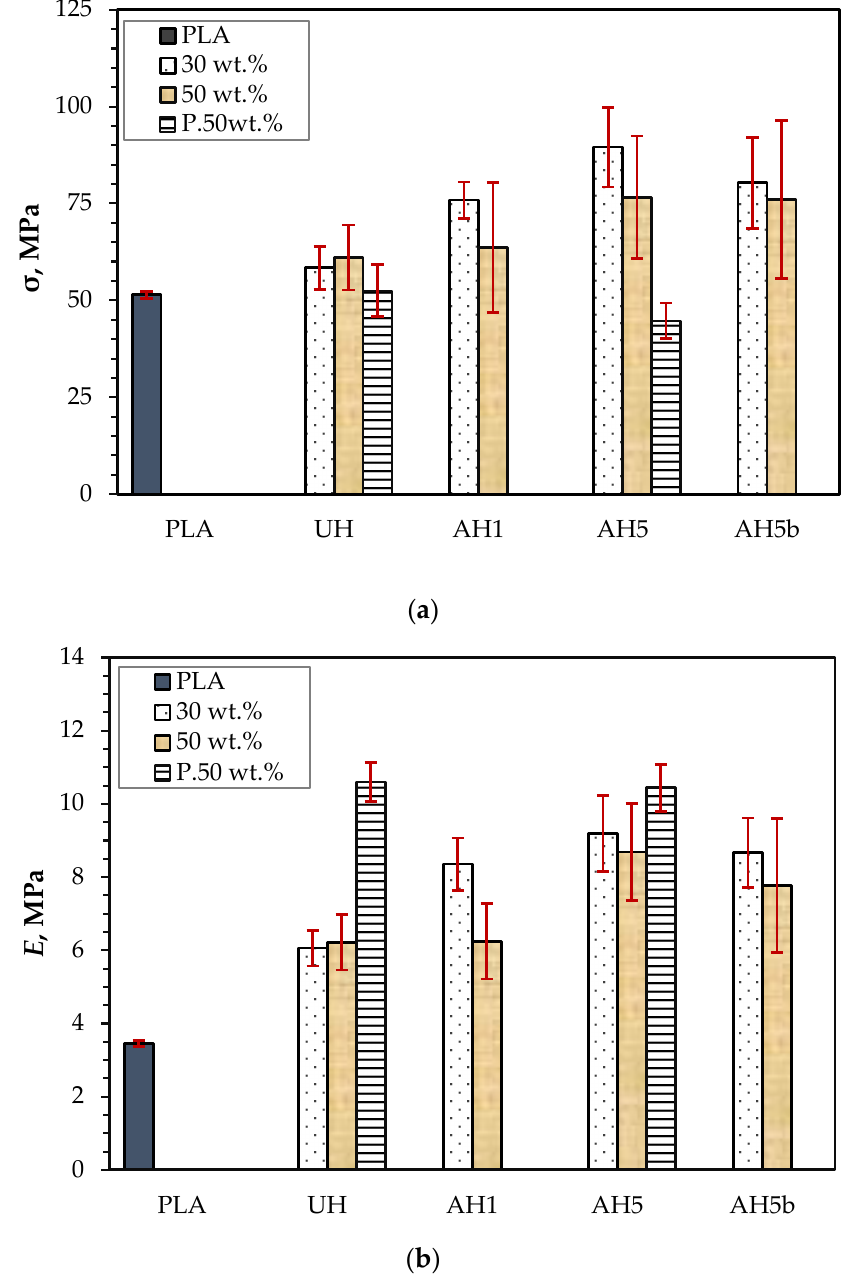
Figure 7. ( a ) Tensile strength ( σ ) and ( b ) Young’s modulus ( E ) of neat PLA and 30 and 50 wt.% untreated hemp fiber reinforced composites (UH) and composites of alkali-treated hemp fibers (AH1, AH5 and